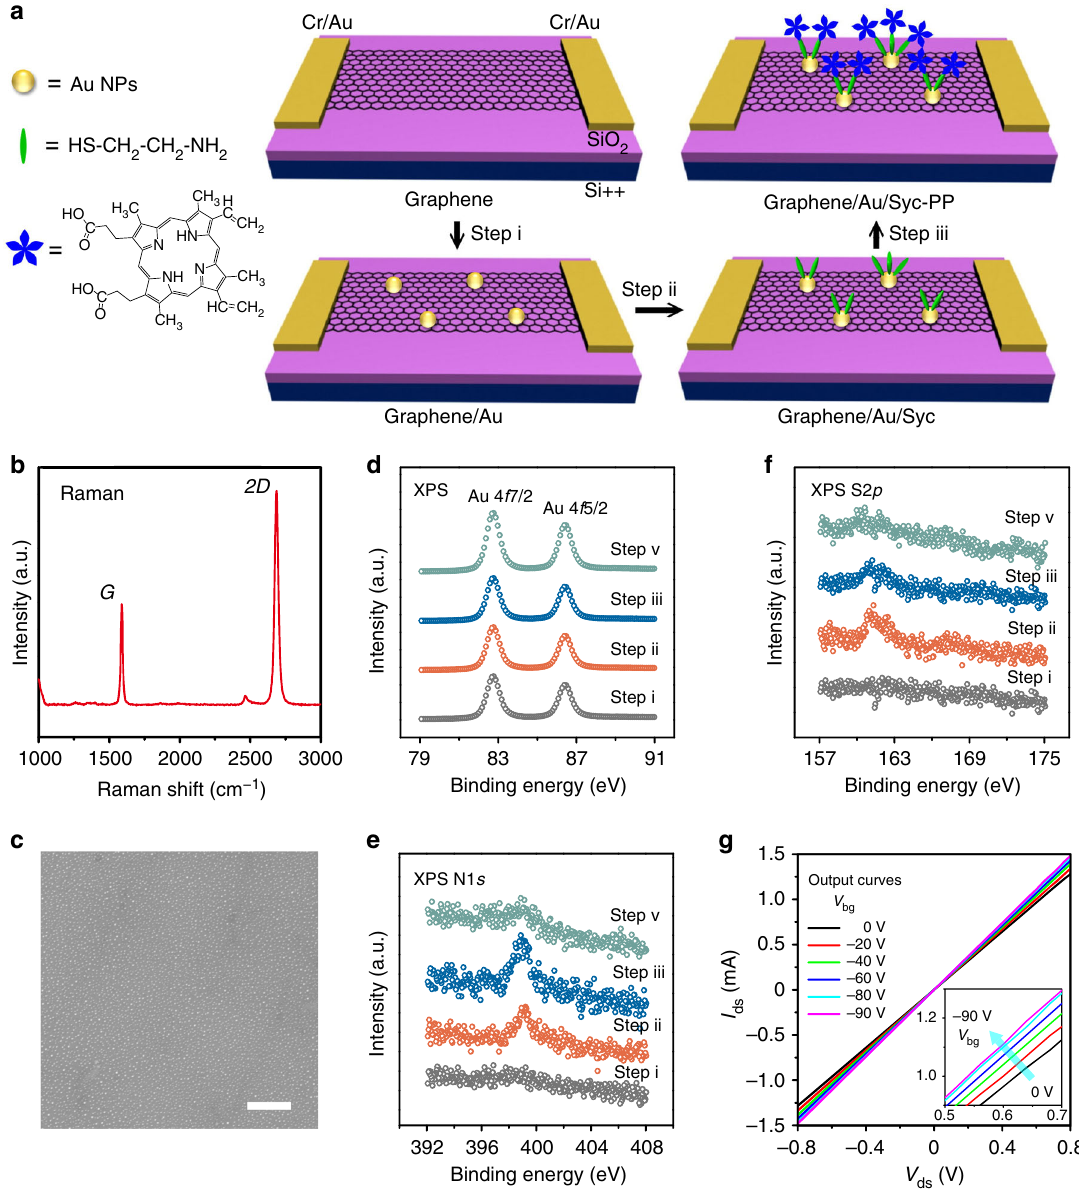
Fig. 1 Fabrication and characterization of a fi eld-effect transistor (FET) sensor. a Schematic diagram of the device fabrication process. b Raman spectrum of a graphene fi lm. c Field-emission scanning electron microscope images of the graphene fi lm decorated with Au nanoparticles (step i). d – f X-ray photoelectron spectroscopic spectra of Au 4 f 7/2 and Au 4 f 5/2 , S 2 p , and N 1 s for (step i) graphene/Au, (step ii) graphene/Au/Cys, (step iii) graphene/Au/ Cys-PP, and (step v) graphene/Au/Cys-PP-Cd 2 + after reaction with (cid:129) OH. g Output characteristics of a graphene/Au/Cys-PP FET sensor ( V bg varies from 0 to − 90 V). The scale bar in c is 200